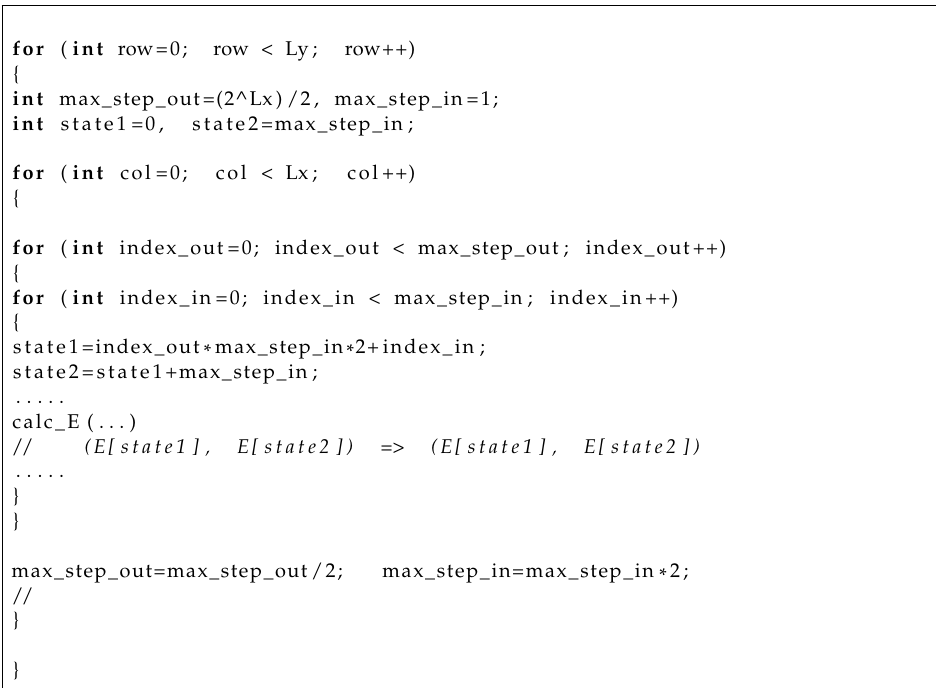
Listing 1. Pseudocode of enumeration rows and columns, splitting states into pairs, calculating new energy